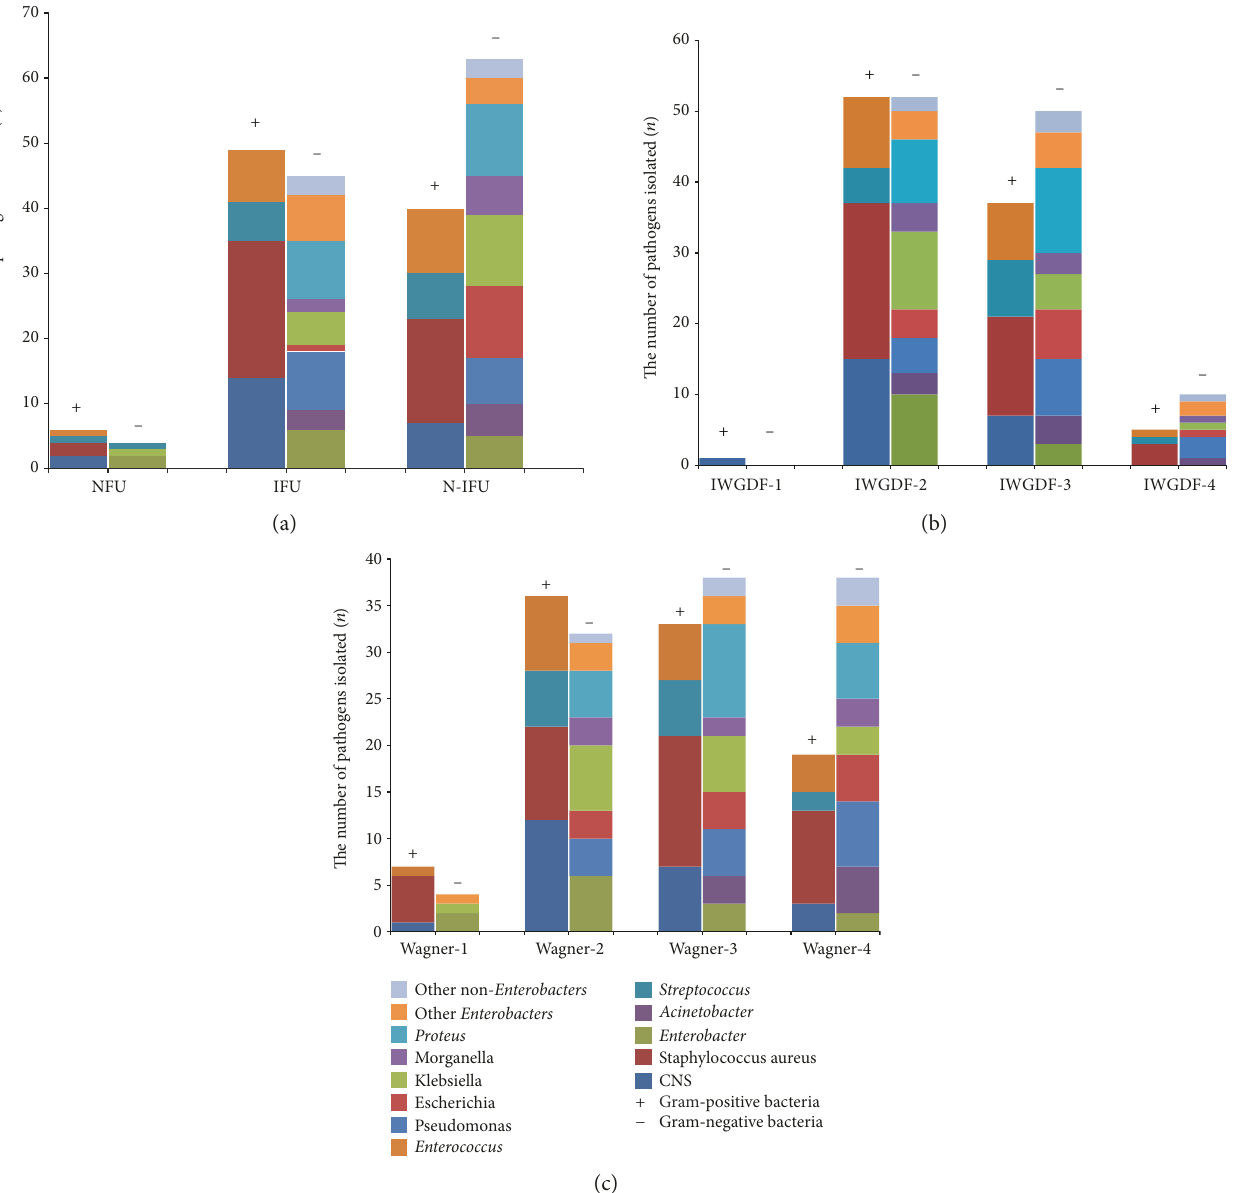
Figure 2: Distribution of bacteria of DFIs of varying Wagner ’ s grades, IDSA/IWGDF grades, and DFU types. (a) The number of bacteria isolated in di ff erent DFU types; (b) the number of bacteria isolated in di ff erent IDSA/IWGDF grades; (c) the number of bacteria isolated in di ff erent Wagner ’ s